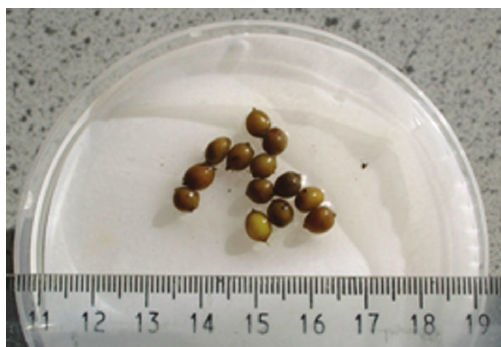
Figure 6: Freshly produced cocoons of L. terrestris housed on a moistened filter paper in a Petri dish. These were produced by 1 earthworm over 1 month.